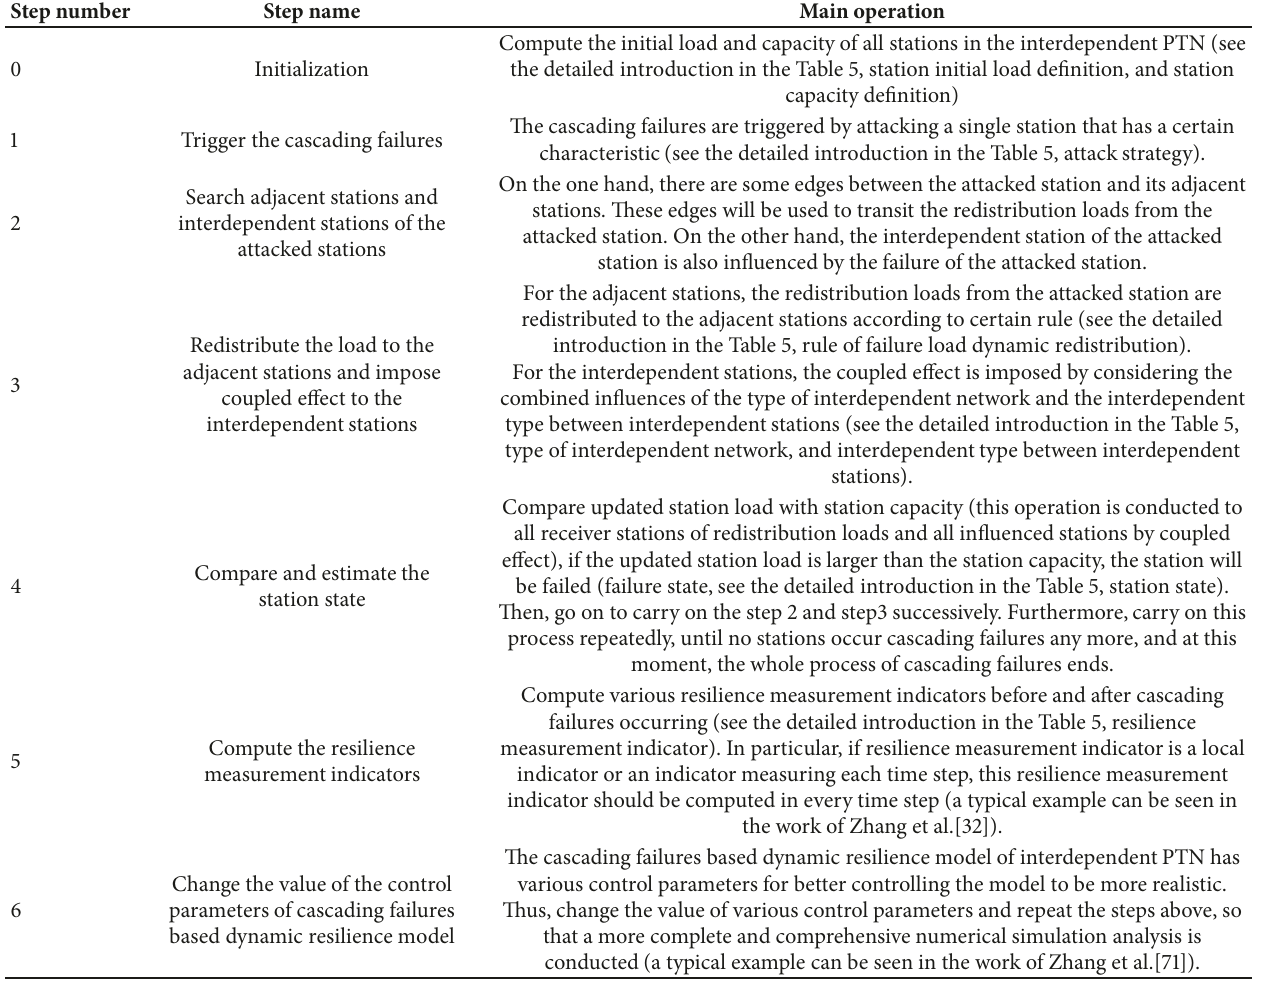
Table 6: Steps of numerical simulation analysis of dynamic resilience of interdependent